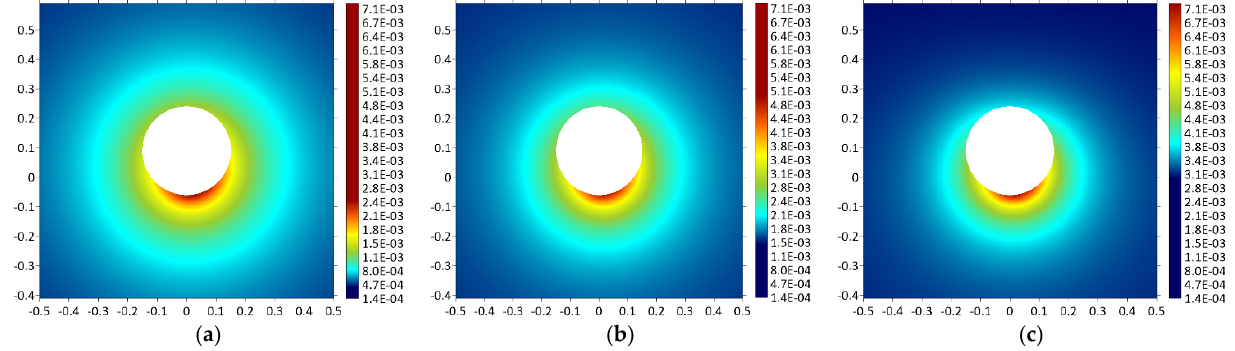
Figure 8. Acoustic pressure sensitivities ( | ∂ p / ∂ k | ) on { ( x , y , z , ) | − 0.5 ≤ y ≤ 0.5, − 0.4 ≤ z ≤ 0.6, x = 0 } cross section under different values of k : ( a ) k = 3; ( b ) k = 6; ( c ) k = 9.